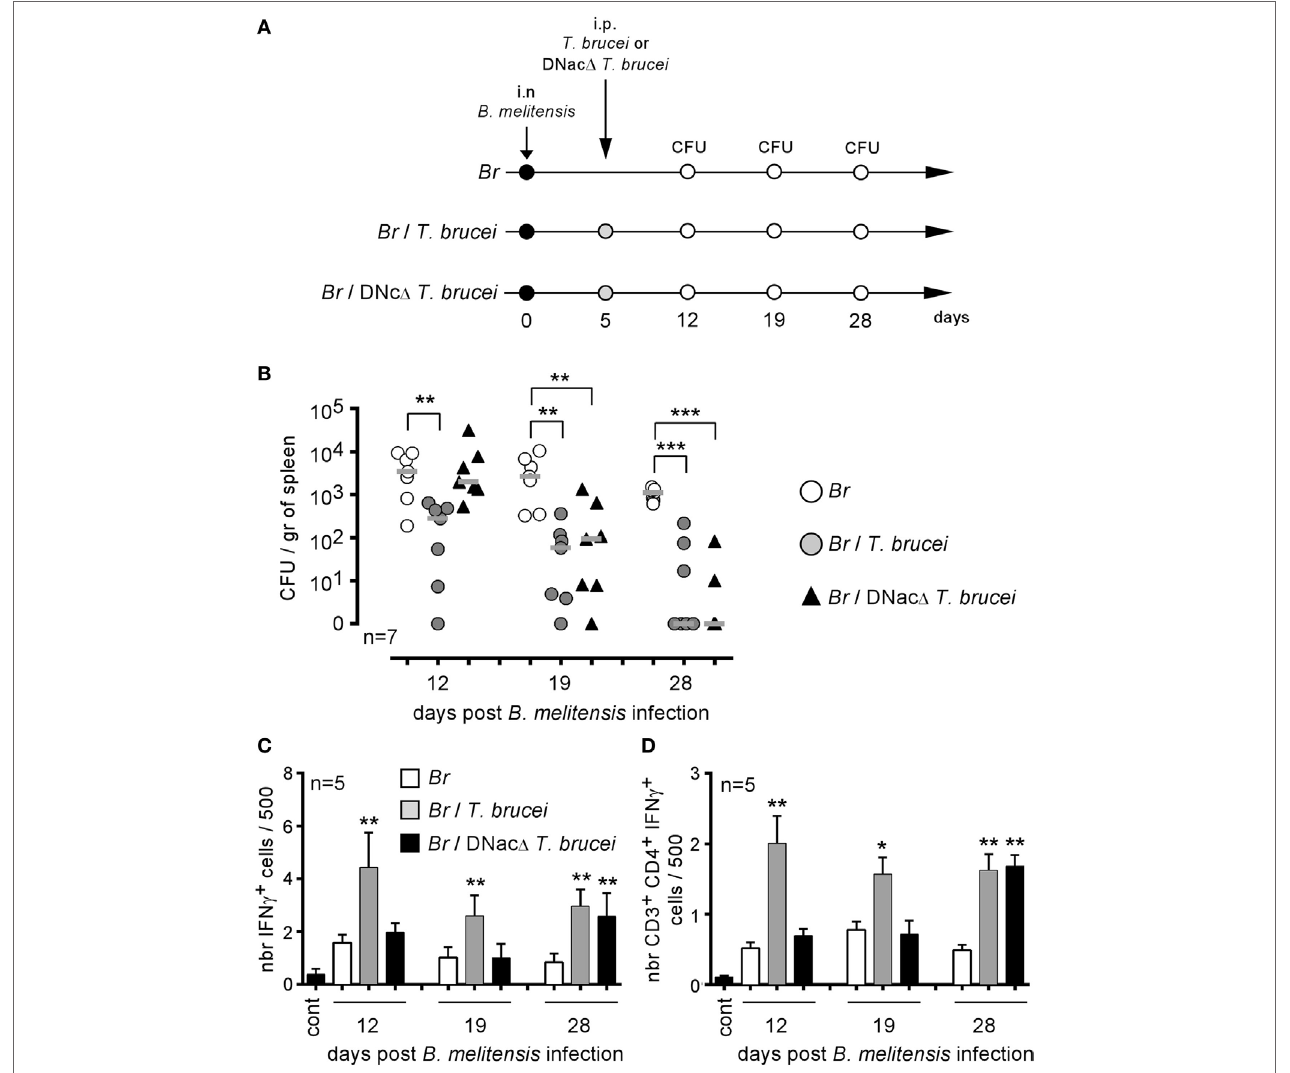
FigUre 7 | Attenuated dominant-negative adenylate cyclase (DNac) mutant of Trypanosoma brucei induced the elimination of Brucella . Wild-type C57BL/6 mice were infected i.n. with 2 × 10 4 CFU of mCherry- Brucella melitensis and, at 7 days postinfection, received an i.p. injection of 5,000 wild-type T. brucei or attenuated DNac mutant of T. brucei in 200 µl of PBS or PBS alone. The mice were euthanized at 12, 19, and 28 days post Brucella infection and the spleen was harvested, as described in panel (a,B) . The data represent the number of colony-forming units per gram of spleen. Gray bars represent the median. n denotes the number of mice used for each group. (c,D) The data represent the mean of the frequency of IFN γ -producing cells (c) and CD3 + CD4 + IFN γ -producing cells (D) in the spleen from five individual spleens as determined by flow cytometry analysis for each group. n denotes the number of mice used for each group (* p < 0.05, ** p < 0.01, *** p < 0.001). These results are representative of at least two independent